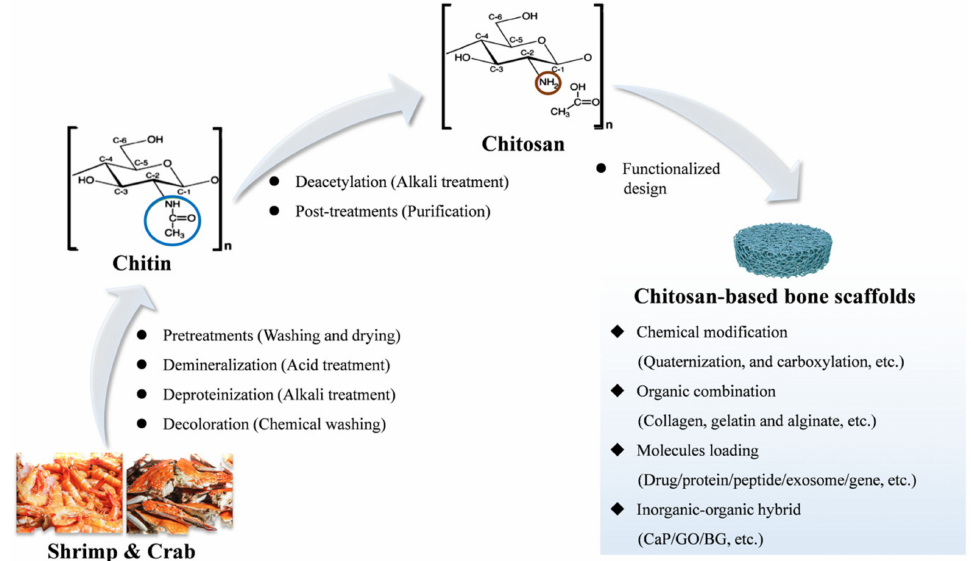
Figure 3. CS is extracted from crustacean shells and applied to the design of bone repair scaffolds through various functionalization